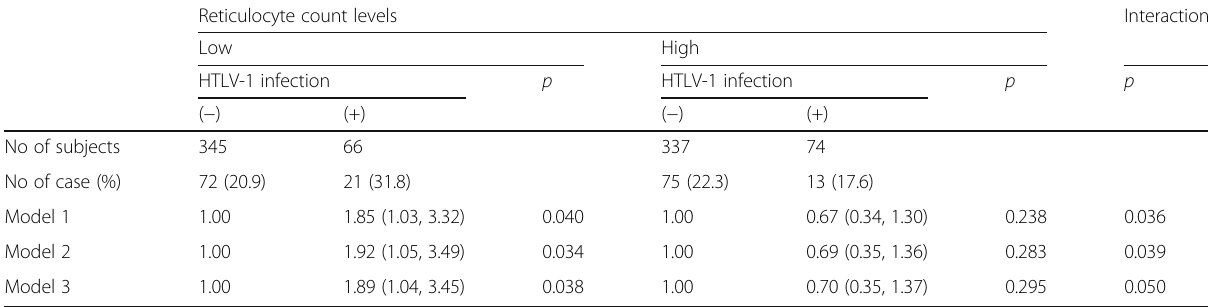
Table 3 Odds ratios (ORs) and 95% confidence intervals (CIs) for advanced periodontitis in relation to human T cell leukemia virus-1 (HTLV-1) infections by status of reticulocyte count levels Reticulocyte count